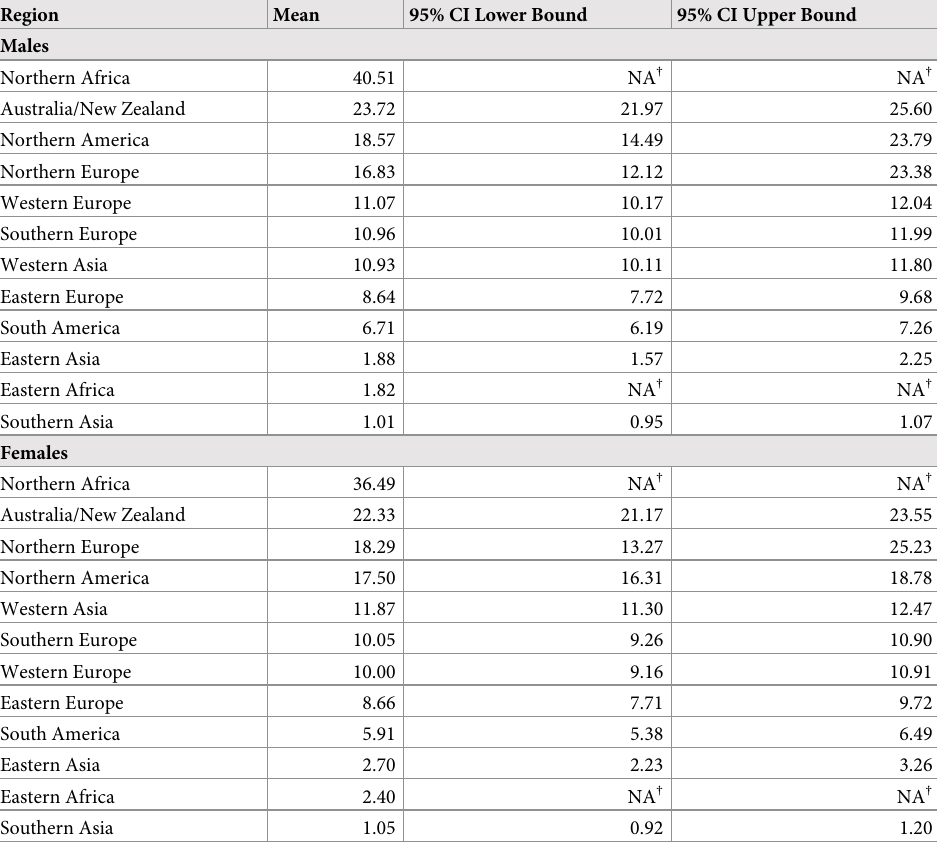
Table 3. Sub analysis of type 1 diabetes incidence rates by sex. � (Age-standardised incidence rates per 100,000 indi- viduals per year with 95% confidence intervals. † For cells labeled as NA, 95% CIs could not be estimated as there was only 1